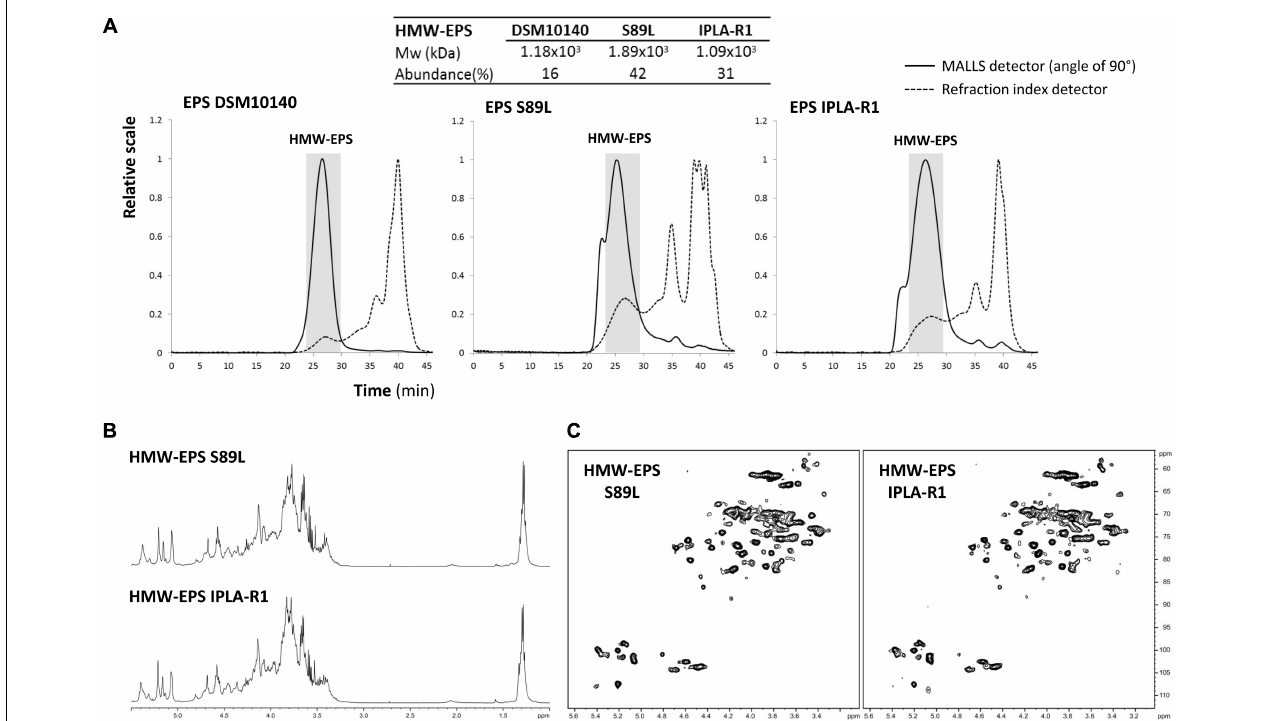
FIGURE 1 | Physical-chemical analysis of EPS isolated from three B. animalis subsp. lactis strains. SEC-MALLS analysis of the EPS-DSM10140, EPS-S89L and EPS-IPLA-R1 showing the molecular weight (Mw) and relative abundance of the high molecular weight (HMW) fraction in each polymer (A) . 1 H-NMR (500 MHz, 343 K) spectra (B) and 500-MHz 1 H- 13 C- HSQC spectra (C) of HMW-EPS purified from EPS-IPLA-R1 and EPS-S89L polymers.